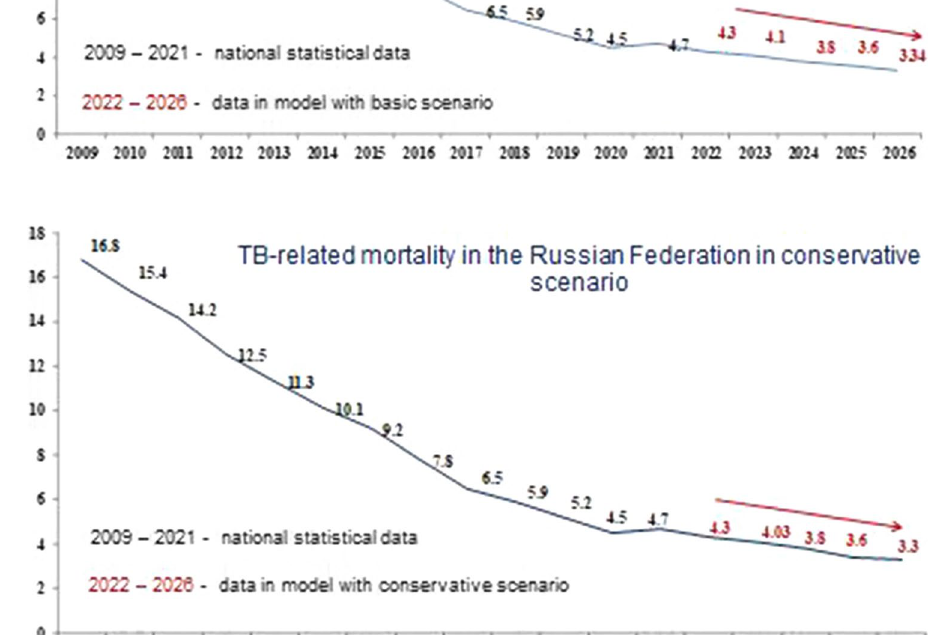
Fig. 7 Forecast of TB-related mortality in the Russian Federa- tion with the basic scenario